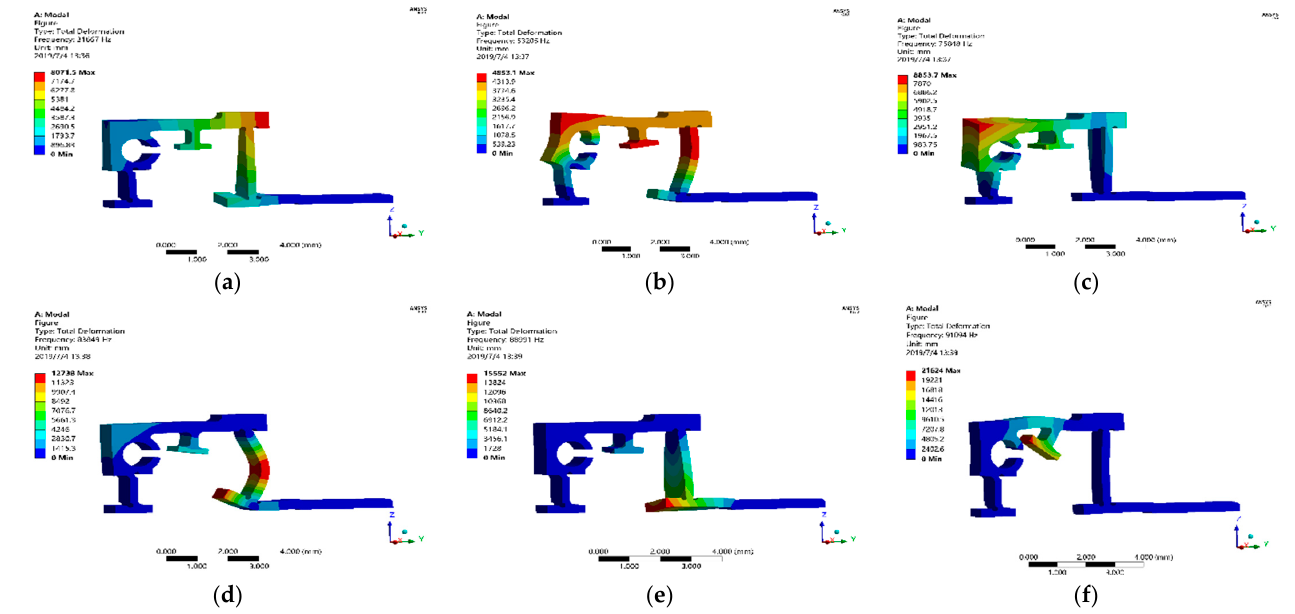
Figure 11. Simulation results of flexible hinge modal analysis ( a – e ) represented from first-order mode to sixth-order mode,